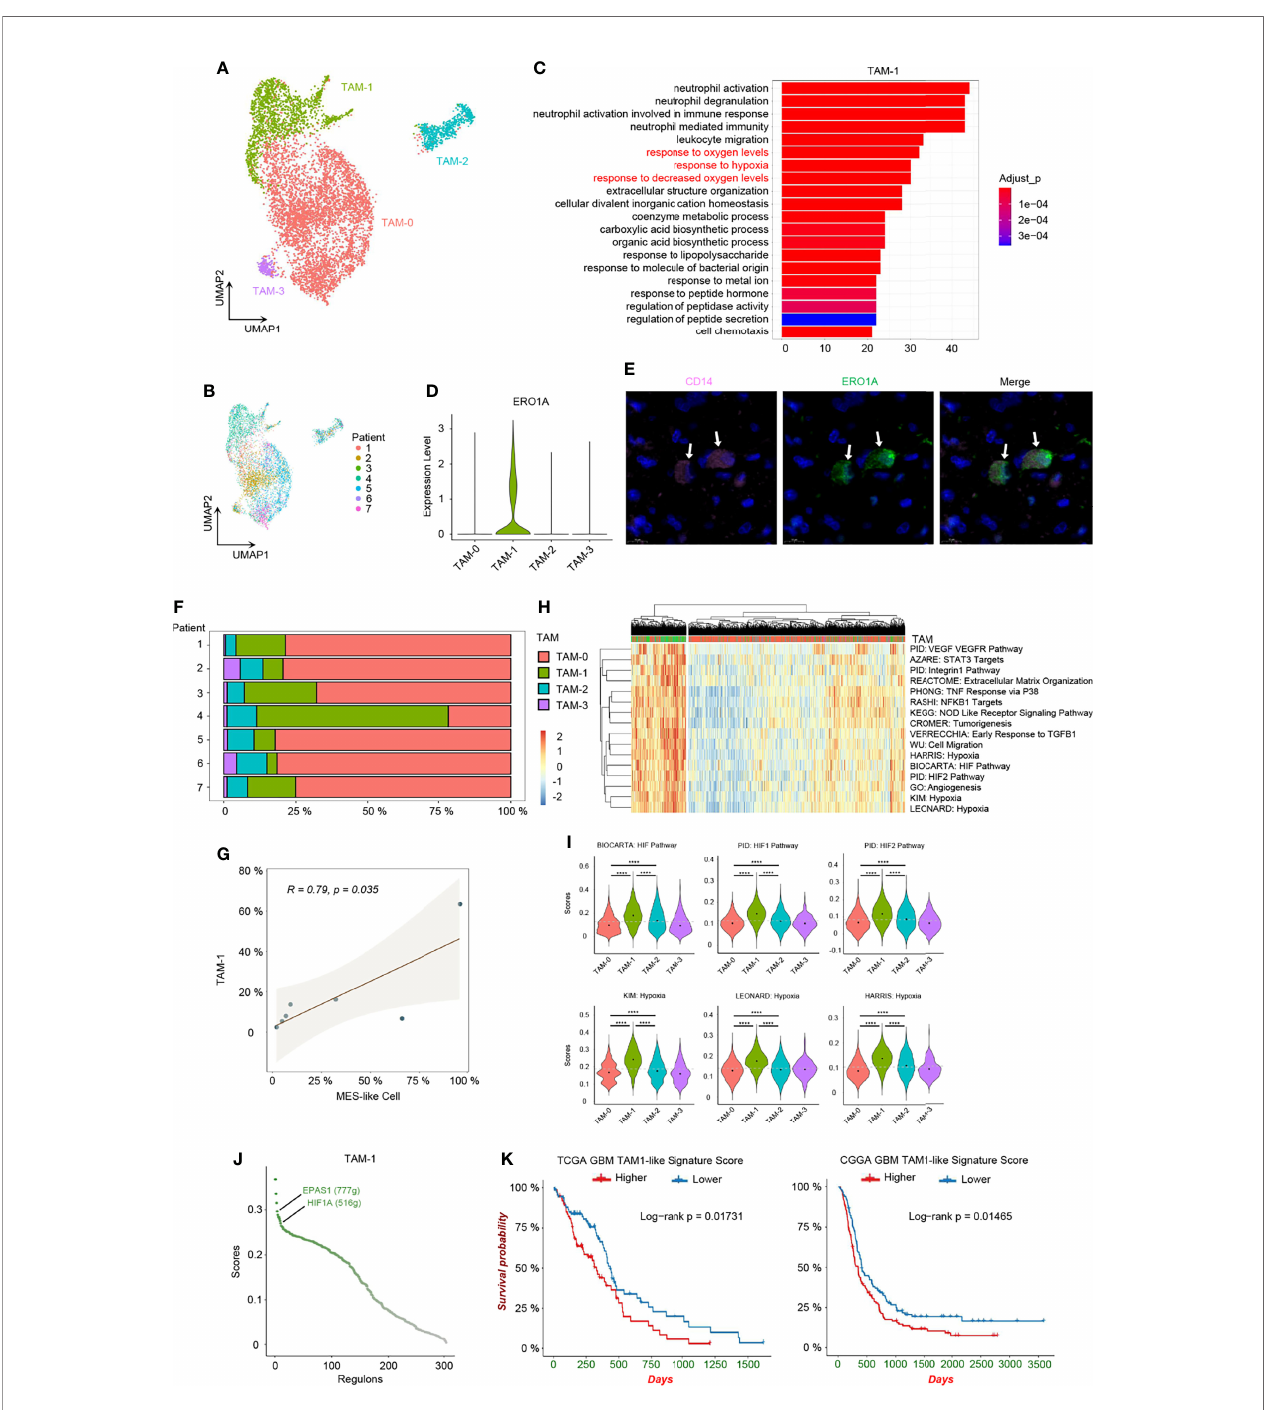
FIGURE 5 | Hypoxia-response TAMs in GBM. (A) UMAP visualization of TAMs. (B) UMAP visualization showing TAMs of individuals. (C) Top 20 function analysis results of TAM-1 cluster. Hypoxia-related biological processes were colored in red. (D) Violin plot of ERO1A expression level in different TAM clusters. (E) Immuno fl uorescence staining for TAM-1 cluster ( CD14+ERO1A+ ) in patient tumor sample. The staining was performed for seven patients, one section each, and a representative image from patient 6 with TAM-1 pointed out by white arrows was shown; scale, 10 m m. The other images are shown in Supplementary Supplementary Figure 6 . (F) Composition ratio of the TAM clusters in individual GBM. (G) Correlation between the number of MES-like and TAM-1 cells. (H) Heatmap of speci fi c gene sets in TAMs. (I) Violin plot of the hypoxia gene set scores in TAMs. TAM-1 was the hypoxia-response cluster in TAMs. (J) The activated regulons in the TAM-1 cluster ranked by the regulon speci fi city score from high to low. (K) Survival analysis of the TAM-1 cluster signatures in TCGA and CGGA GBM databases, respectively. Gray dash line, average score; **** p < 0.0001. See also Supplementary Figures 5 and 6 , and Supplementary Tables 3 and 6